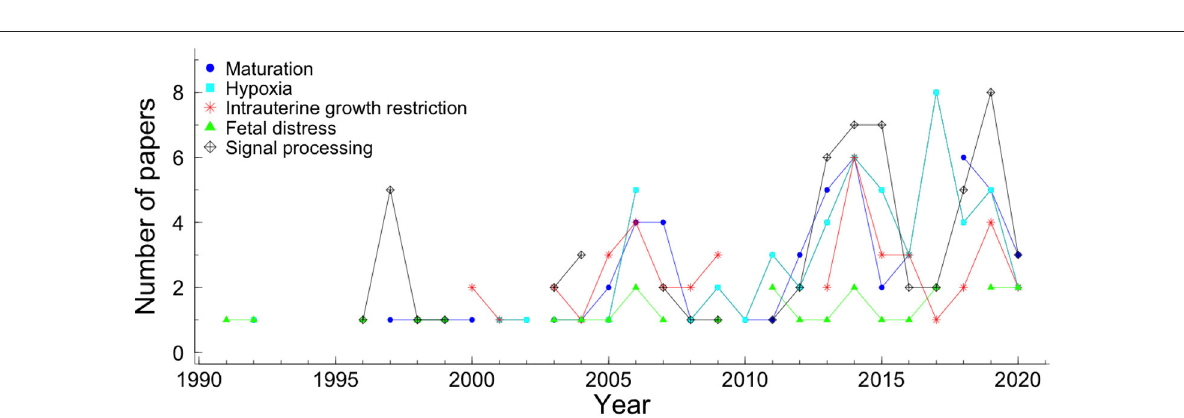
FIGURE 7 | The five most cited research objectives of the papers that applied non-linear methods in fHR, by year of publishing. The colors and symbols represent the different research objectives. The blue circle, cyan square, star red, green triangle, and black diamond plus represent maturation, hypoxia, intrauterine growth restriction, fetal distress, and signal processing,